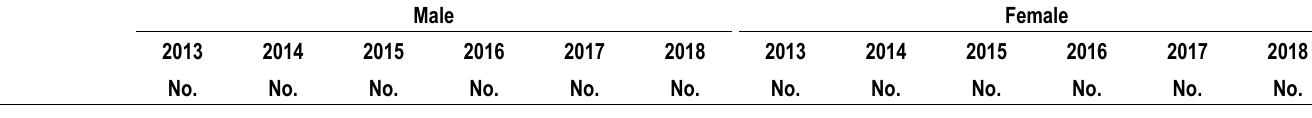
Table 11a. Stage 3 (AIDS) attributed to injection drug use, by selected characteristics, 2013–2018—United